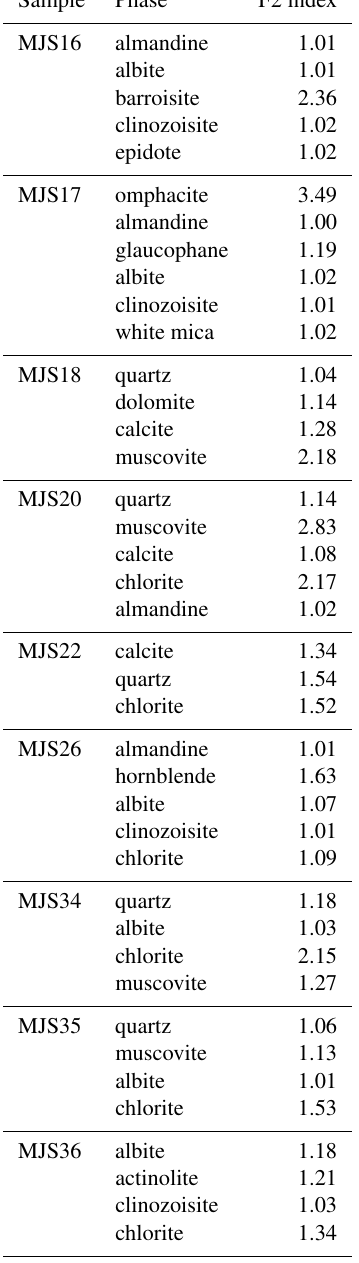
Table A1. F2 indices after Bunge (1982) for all mineral phases of the